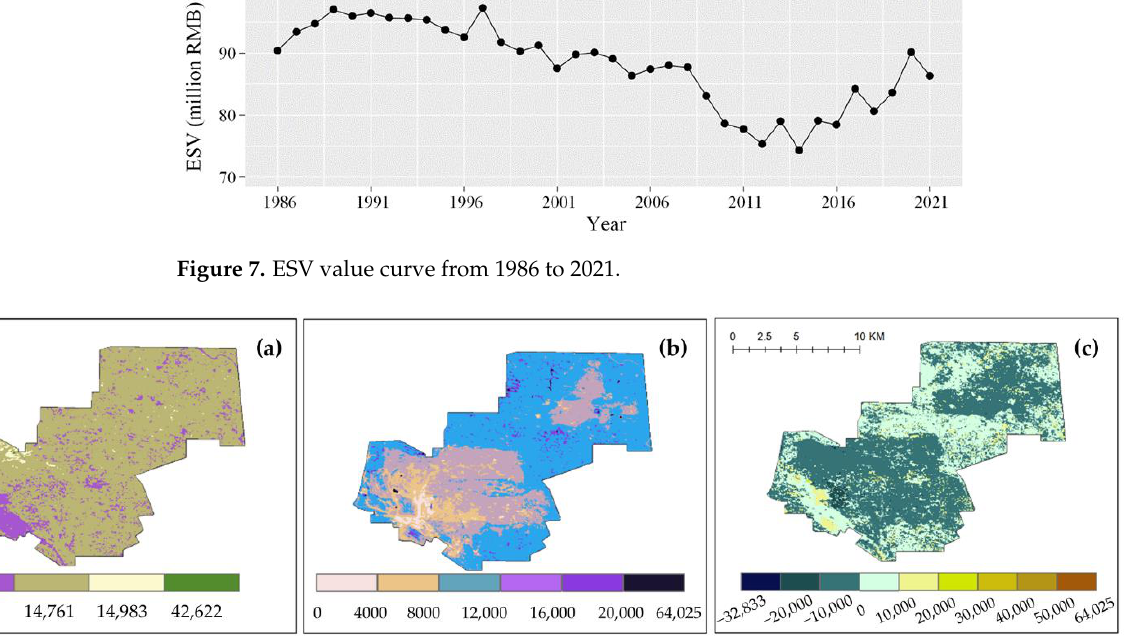
Figure 8. Changes in ECE during 1986 – 2021 (million RMB). ( a ) Ideal ecological cumulative value (IECV), ( b ) real ecological cumulative value (RECV), ( c ) real ecological cumulative loss (RECL). Table 3. IECV, RECV, and RECL in different regions during 1986 – 2021 (million RMB). ECE